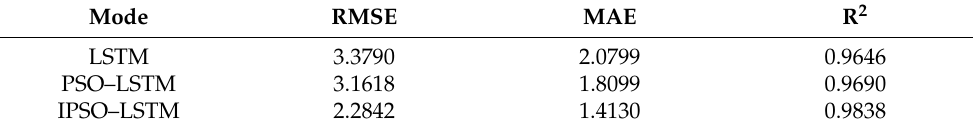
Table 3. Evaluation indexes of different models in a single fusion pattern.